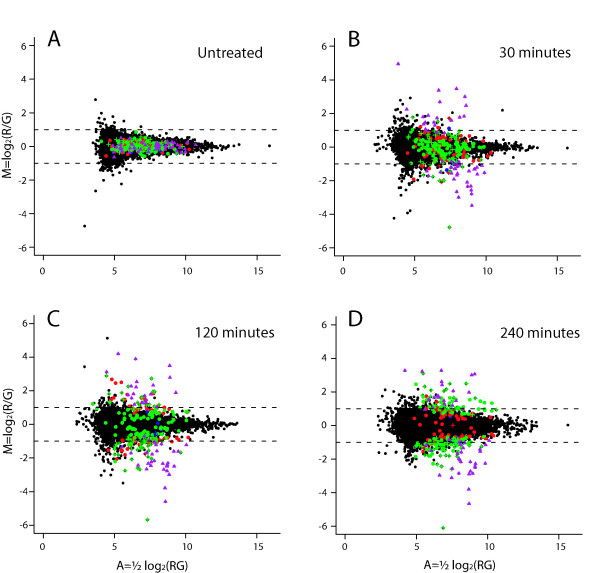
General overview of the filtered and normalised data for each of the time point comparisons. (A-D) The average of the replicated hybridisations for each time point is presented using MA-plots (samples are labelled with a Red dye and the reference with a Green dye). An increased noise at lower signal intensities is observed, as expected, as no absolute cut-off level for signal intensity is used in the data filtering process. However, genes at the low-intensity region are not identified as differentially expressed genes due to variation between the replicated hybridisations. (B) At 30 minutes the overall pattern is drastically changed, with several genes showing a >2-fold change in expression levels. (C-D) The same general pattern is observed for the data corresponding to 120- and 240-min treatments. An increasing number of differentially expressed genes are, however, observed. For (A-D) genes differentially expressed at one time point ● (30 min blue, 120 min red, 240 min green), two time points + (30 and 120 min red, 30 and 240 min blue, 120 and 240 min green) or three time points ▲ (purple) time points are listed in Additional data files 1 and 2 available online. Dashed lines indicate two-fold differential expression.